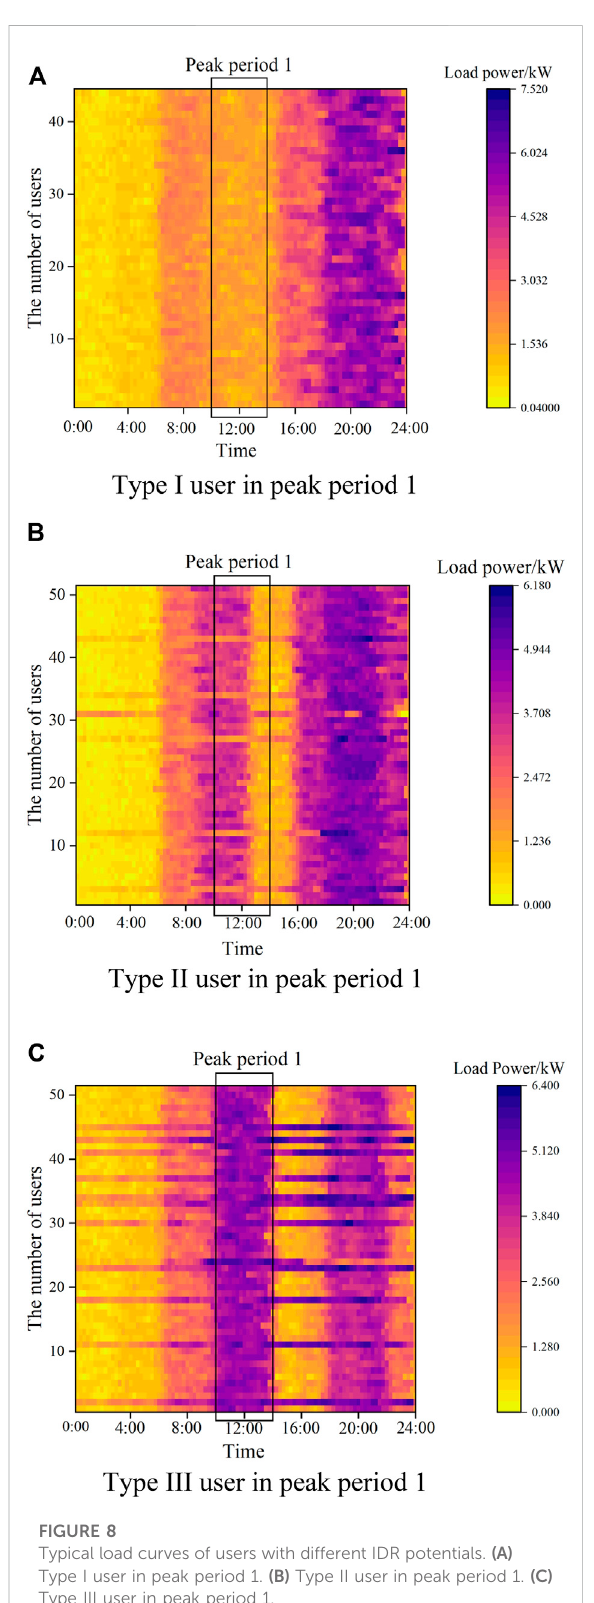
FIGURE 8 Typical load curves of users with different IDR potentials. (A)